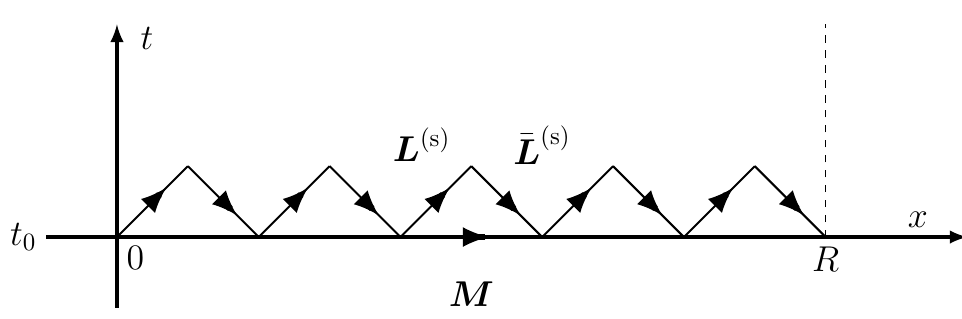
Figure 5 . By replacing the integration over the segment at the time slice t = t 0 by integration over the light-cone pieces, the monodromy matrix can be expressed as a product of the elementary \light-cone" transport matrices: M ( (cid:22) ) = Q